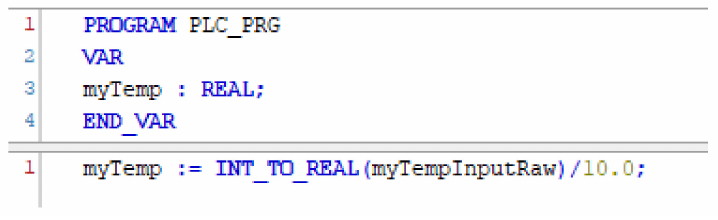
Figure 7. Code for RTD sensor temperature readings.